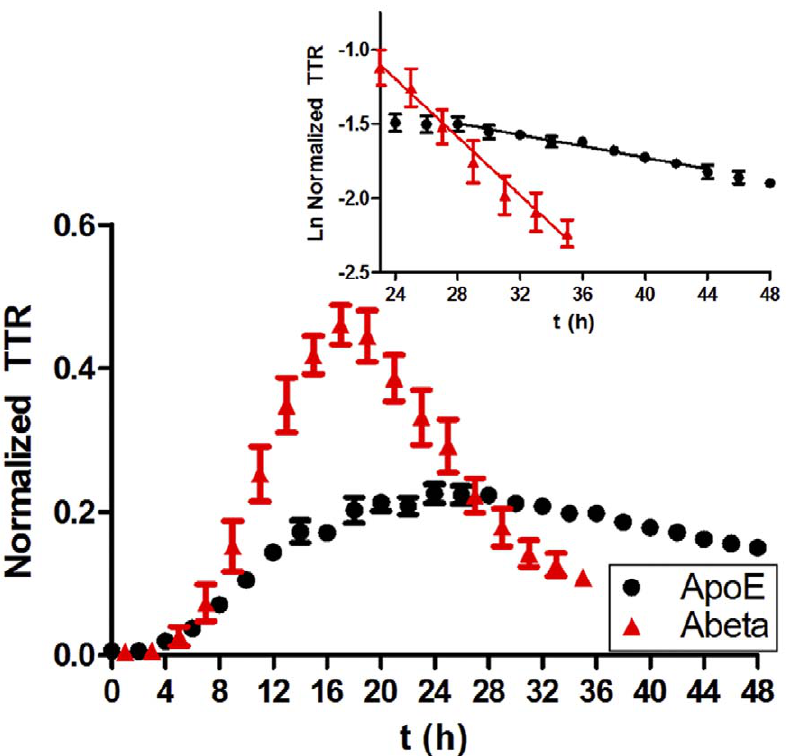
Figure 6. CNS-ApoE has slower kinetics than CNS-A b . The average of 4 YNC participants’ ApoE and A b (total) 13 C 6 -leucine enrichment curves are shown. A b reaches a higher TTR than ApoE and clears the 13 C 6 -leucine label 4 6 faster than ApoE. ApoE (total:LAVYQAGAR, black circle); A b (total, red triangles) (n=4, error bars represent SEM).